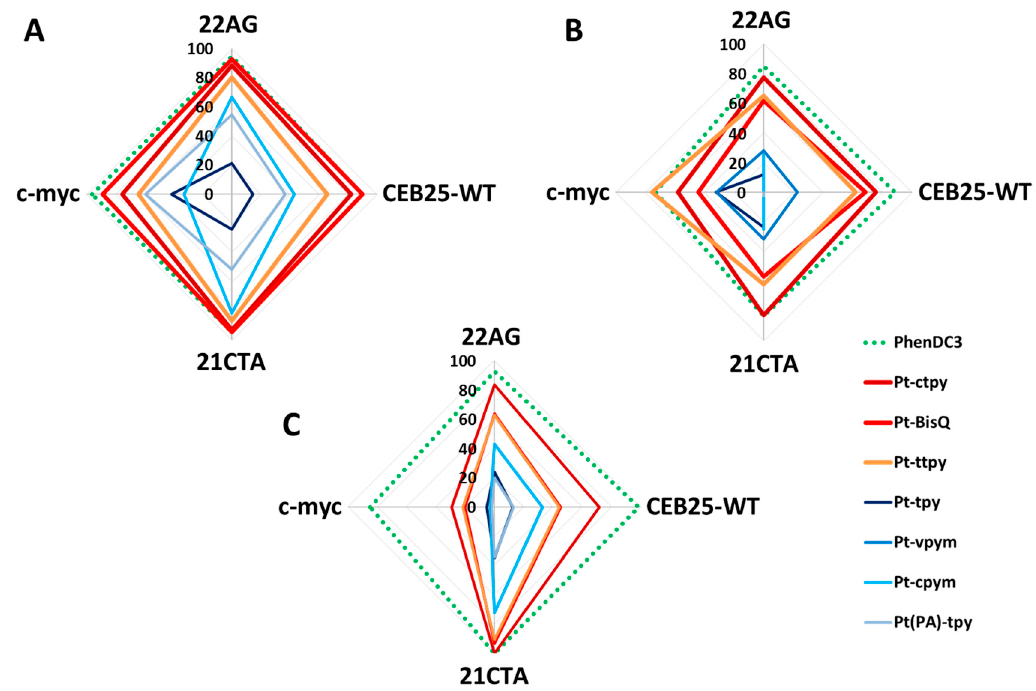
Figure 3. The radar plot representing the percent of the probe displacement at 1 µM of the Pt(II) complexs ( Pt-ctpy , Pt-BisQ , Pt-ttpy , Pt-tpy , Pt-vpym , Pt-cpym , and Pt(PA)-tpy ) and the PhenDC3 used as control for the G4-FID assay. The experiments are performed in the presence of 22AG, c-myc, 21CTA, and CEB25-WT with ( A ) Thiazole Orange (TO) (2 eq.), ( B ) TO-PRO-3 (2 eq.), or ( C ) Phen DV (1.5 eq.) in K + 100 buffer. The values are given in Tables S2, S3, and S4.